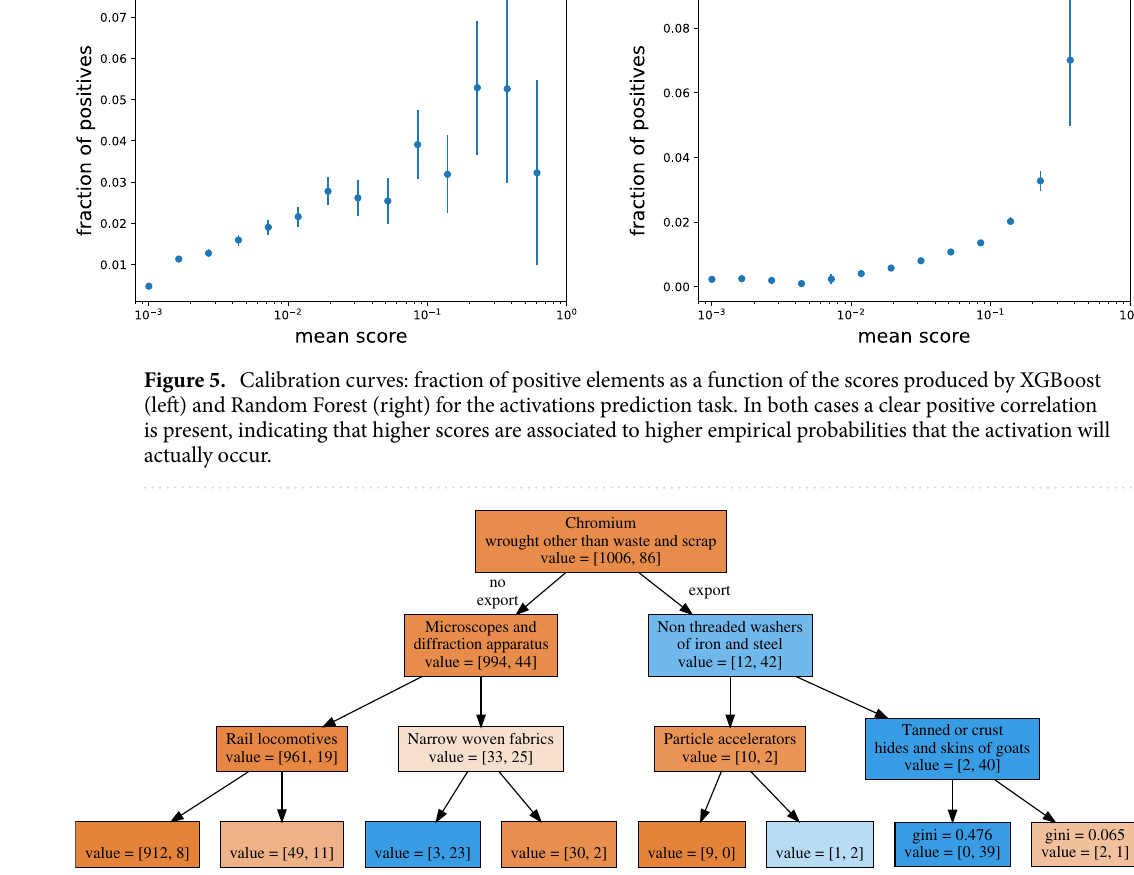
Figure 6. A representative decision tree to forecast the export of the product valves and tubes . The root product, chromium , has a well known technological relation with the target product, and in fact is able to discriminate against future exporters with high